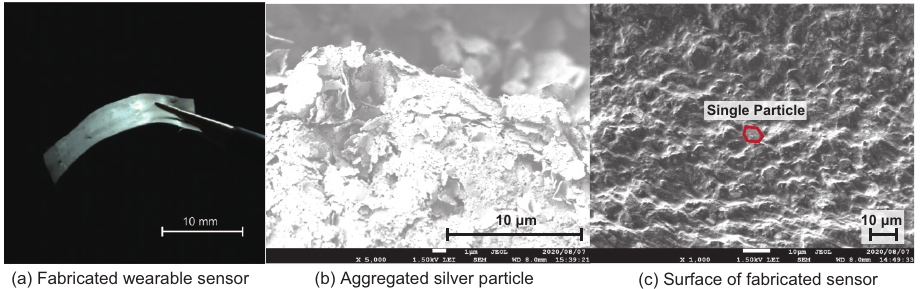
Figure 2. Images of the fabricated wearable sensor. ( a ) Overall image of the sensor (see Supple- mentary Material Video S1). ( b ) The flat silver particles are aggregated in the original form. ( c ) By admixing with the silicone polymer, the particles are spread evenly in the mixture. A typical image of a single silver particle is indicated with red